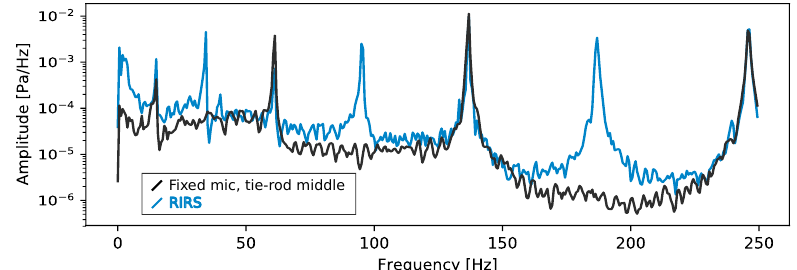
Figure 7. Peak recognition with and without RIRS. Linear spectrum of two signals obtained measuring the same tie-rod with a microphone. The black line is the result of keeping sensor and hammer in the middle of the tie-rod; the blue line is the result of using the RIRS technique, measuring in multiple positions.